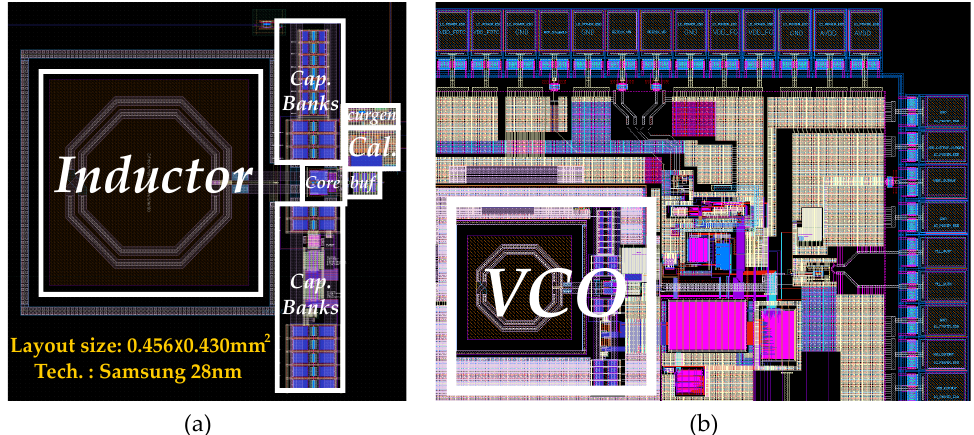
Figure 10. Layout design of ( a ) proposed VCO block and ( b ) entire PLL block including VCO block.